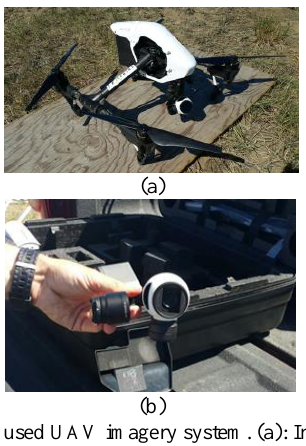
Figure 6. The used UAV imagery system. (a): Inspire 1 UAV from DJI. (b): X3 RGB camera Image #